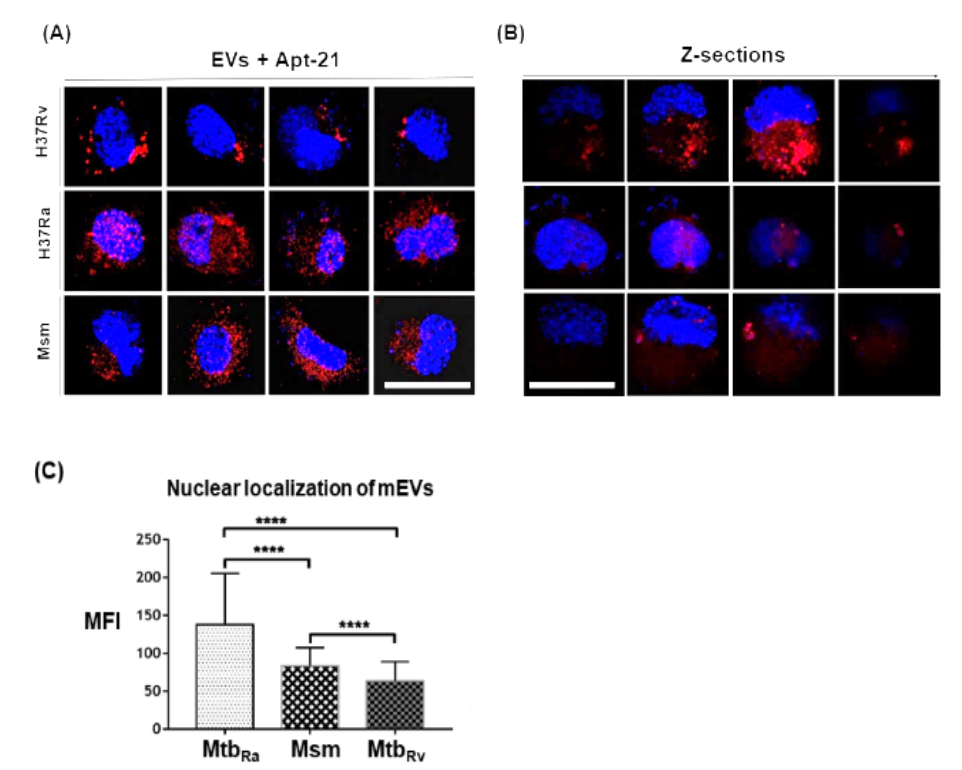
Figure 5. Aptamer-21 detects mycobacterial EVs post uptake by THP-1. ( A , B ): PMA-differentiated THP-1 were first incubated with mEVs from three mycobacterial strains (Msm, H37Ra and H37Rv) for 2 h at 37 ◦ C, followed by 2 h exposure with Cy5-labelled apt-21 (100 pm). The images were acquired at 60× using FV 3000 software. ( B ) Z-sections were acquired to assess the localisation of mEVs in the nucleus of THP-1 macrophages. ( C ) mEVs localized to the nucleus were quantified by cellSens Dimension software and a student t-test (unpaired) was performed. Mtb Rv , H37Rv (pathogenic); Mtb Ra , H37Ra (attenuated); Msm, mc 2 155 ( M. smegmatis , avirulent); MFI, mean fluorescence intensity. **** p < 0.0001. The images were captured at 60X magnification. White bars in ( A , B ) bottom right and left-most panels indicate scale bar of 20 µm (applies to all 24 panels).